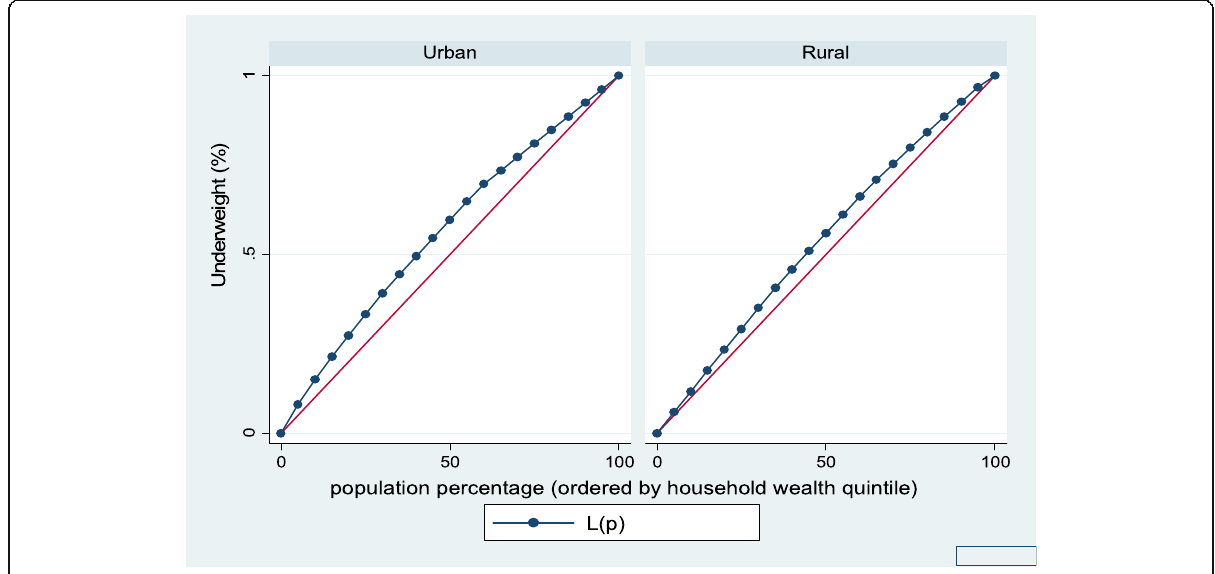
Fig. 3 Urban-rural Lorenz curve for underweight